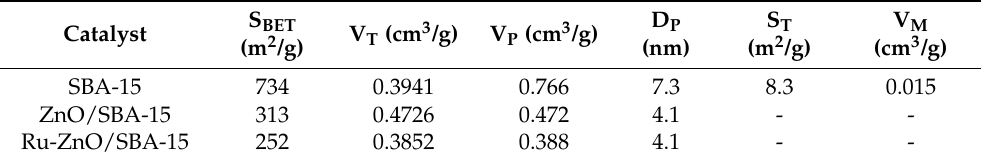
Figure 4. Textural analysis of the as-prepared SBA-15 supports: ZnO/SBA-15 and Ru-ZnO/SBA-15 composites: ( a ) N 2 adsorption-desorption isotherms; ( b ) BJH pore size distribution. Table 1. Physicochemical properties of the as-synthesized SBA-15 supports: ZnO/SBA-15 and Ru-ZnO/SBA-15 composites.